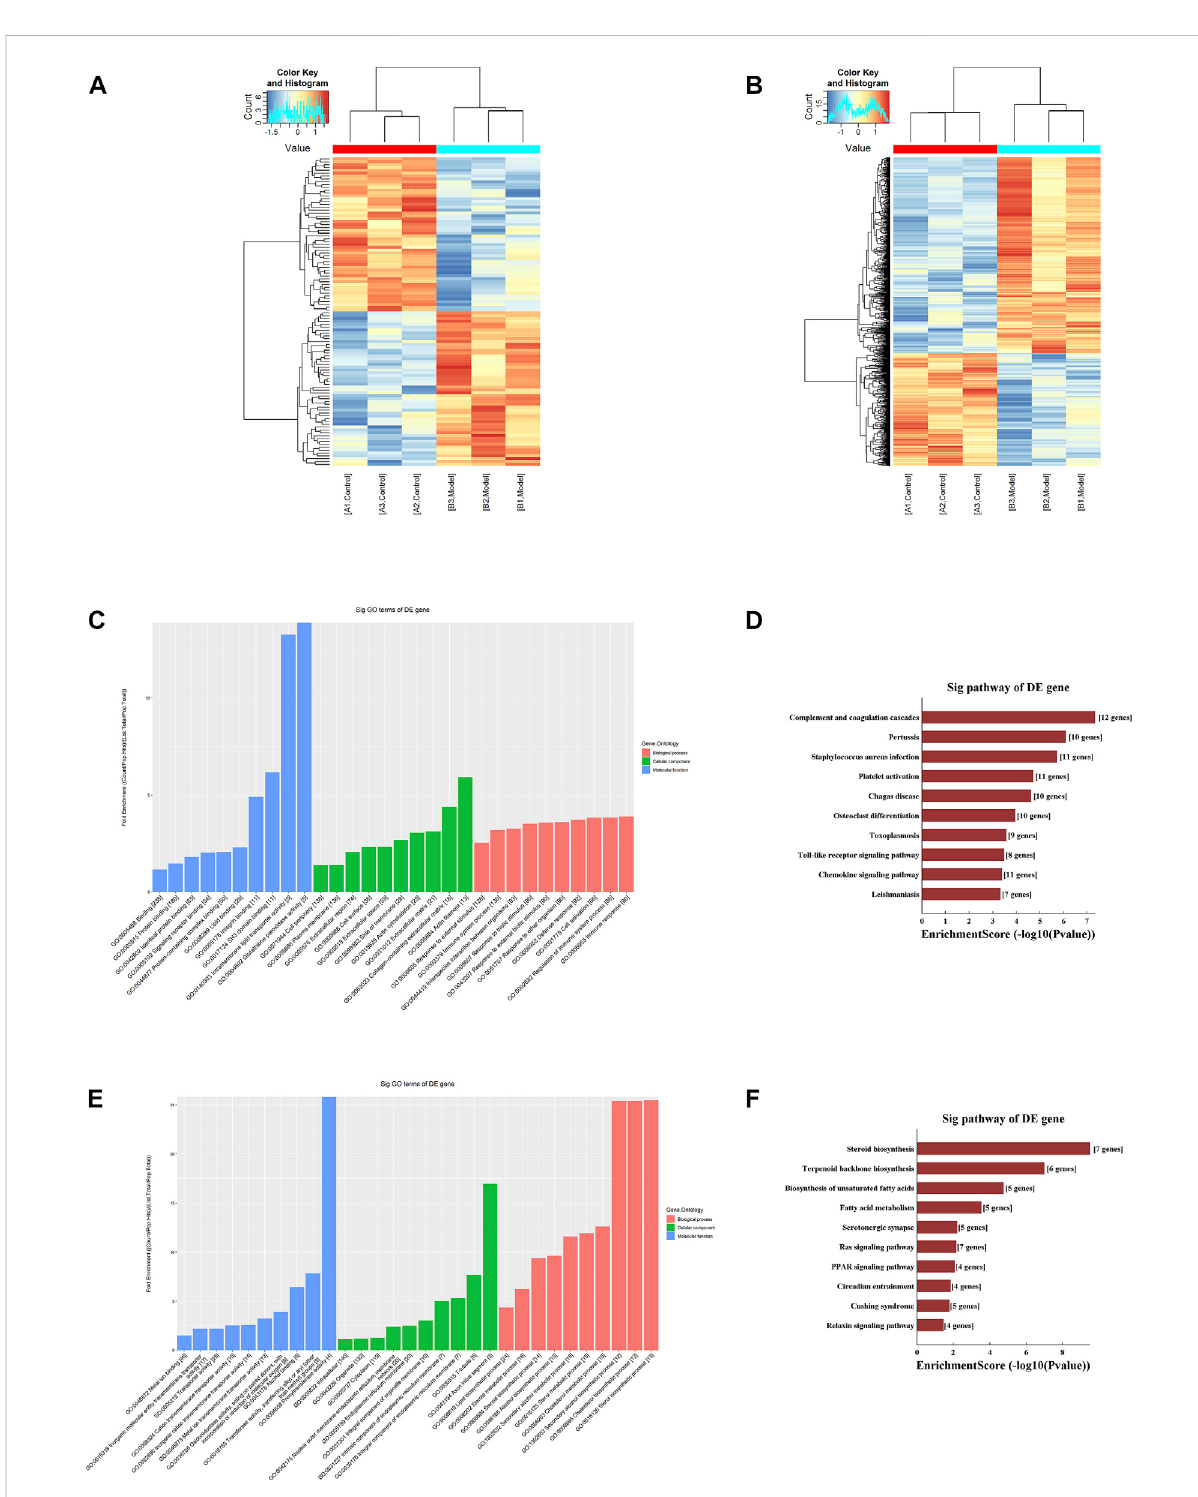
M 6 A modi fi cation pro fi les (A) Hierarchical clustering analysis of the differentially methylated lncRNAs (B) Hierarchical clustering analysis of the differentially methylated mRNAs (C) GO functional analysis of the hypermethylated mRNAs (D) KEGG pathway enrichment analysis of the hypermethylated mRNAs (E) GO functional analysis of the hypomethylated mRNAs (F) KEGG pathway enrichment analysis of the hypomethylated